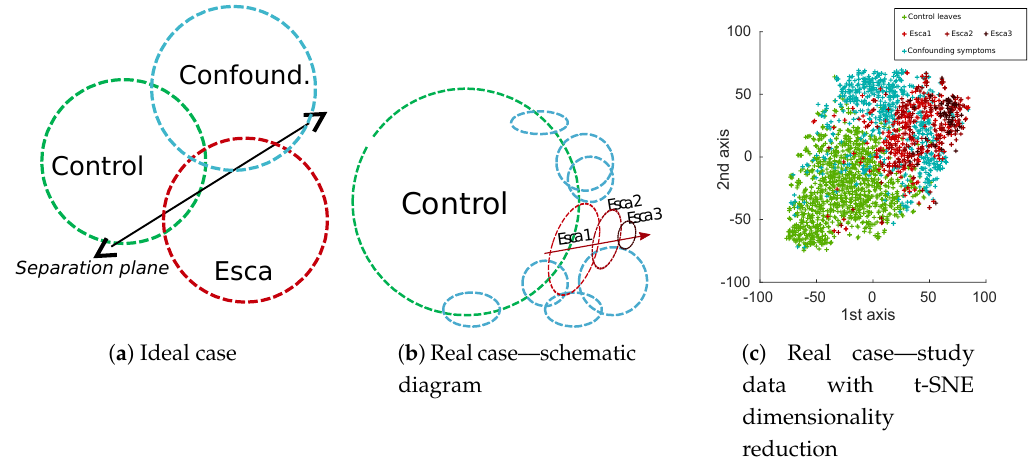
Figure 5. Schematic comparison of ideal ( a ) and real ( b ) class balance in esca leaf disease study. ( c ) Dimensionality reduction of feature maps extracted from the best performing approach in this paper (MobileNet off-the-shelf features from the 12th